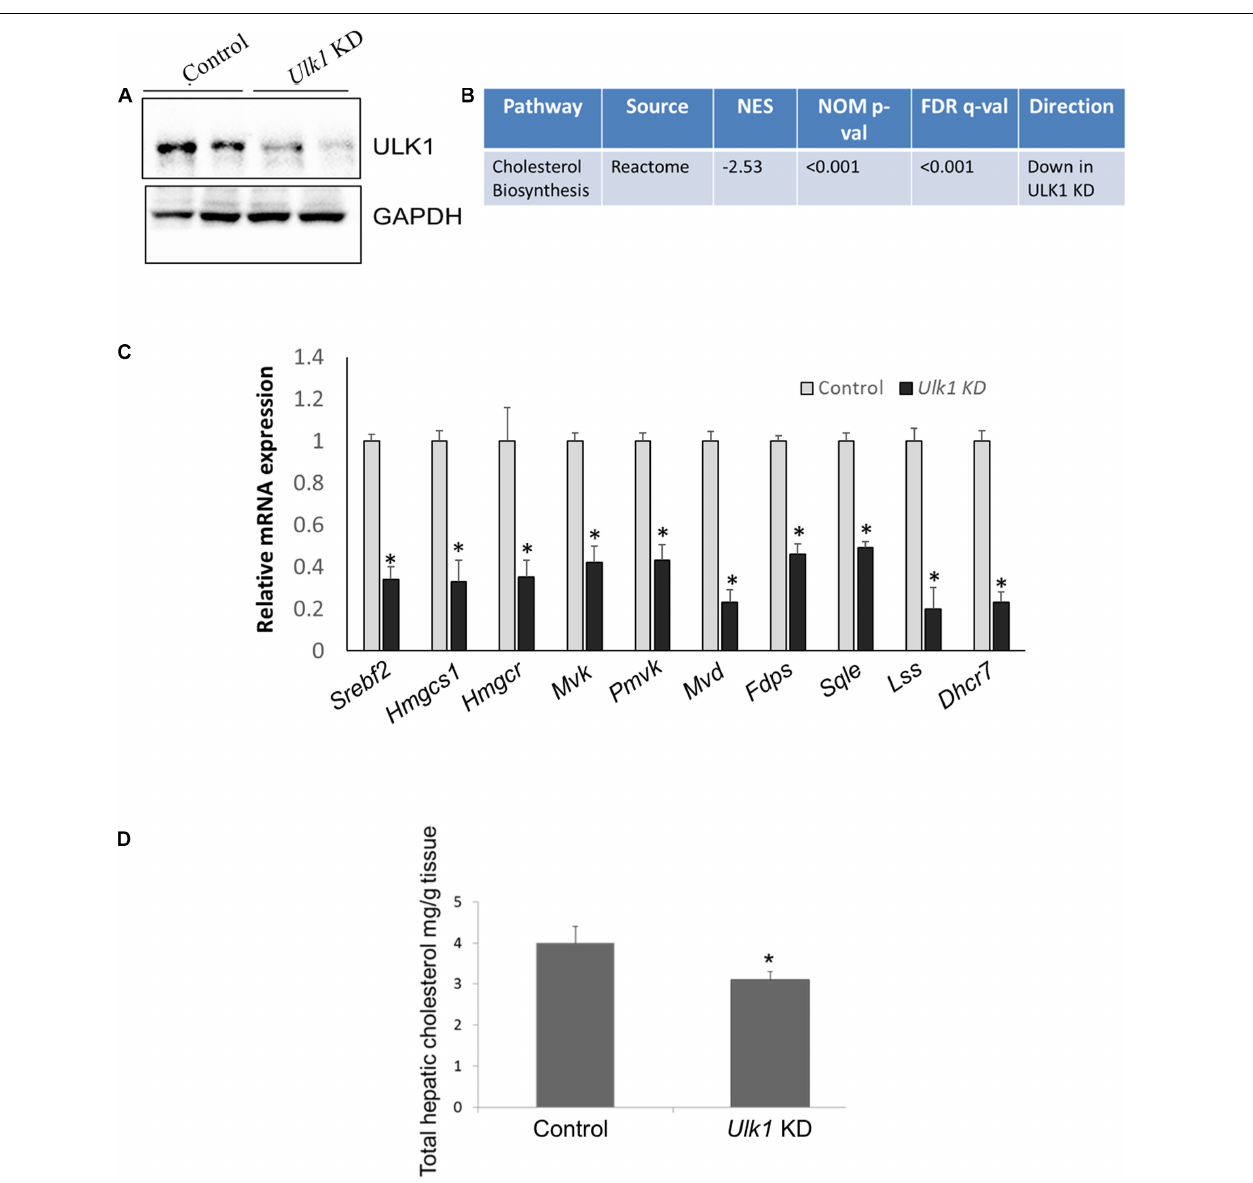
FIGURE 2 | ULK1 regulates mevalonate/cholesterol biosynthesis pathway gene expression in mouse liver. (A) Representative immunoblot showing silencing efficiency of ULK1 in mouse liver treated with hydrodynamic tail vein delivered ± Ulk1 siRNA (40 ug/72 h). (B) Microarray derived transcriptomic pathway analysis in mouse liver upon Ulk1 KD as described above. (C) qRT-PCR validation of mevalonate/cholesterol biosynthesis pathway genes ± Ulk1 siRNA (40 ug/72 h) in AML12 mouse liver. Values are means ± SD ( n = 4), ∗ p < 0.05. (D) Total cholesterol content in hepatic lipid extracts in mouse liver ± Ulk1 siRNA (40 ug/72 h). Values are means ± SD ( n = 4, * p <